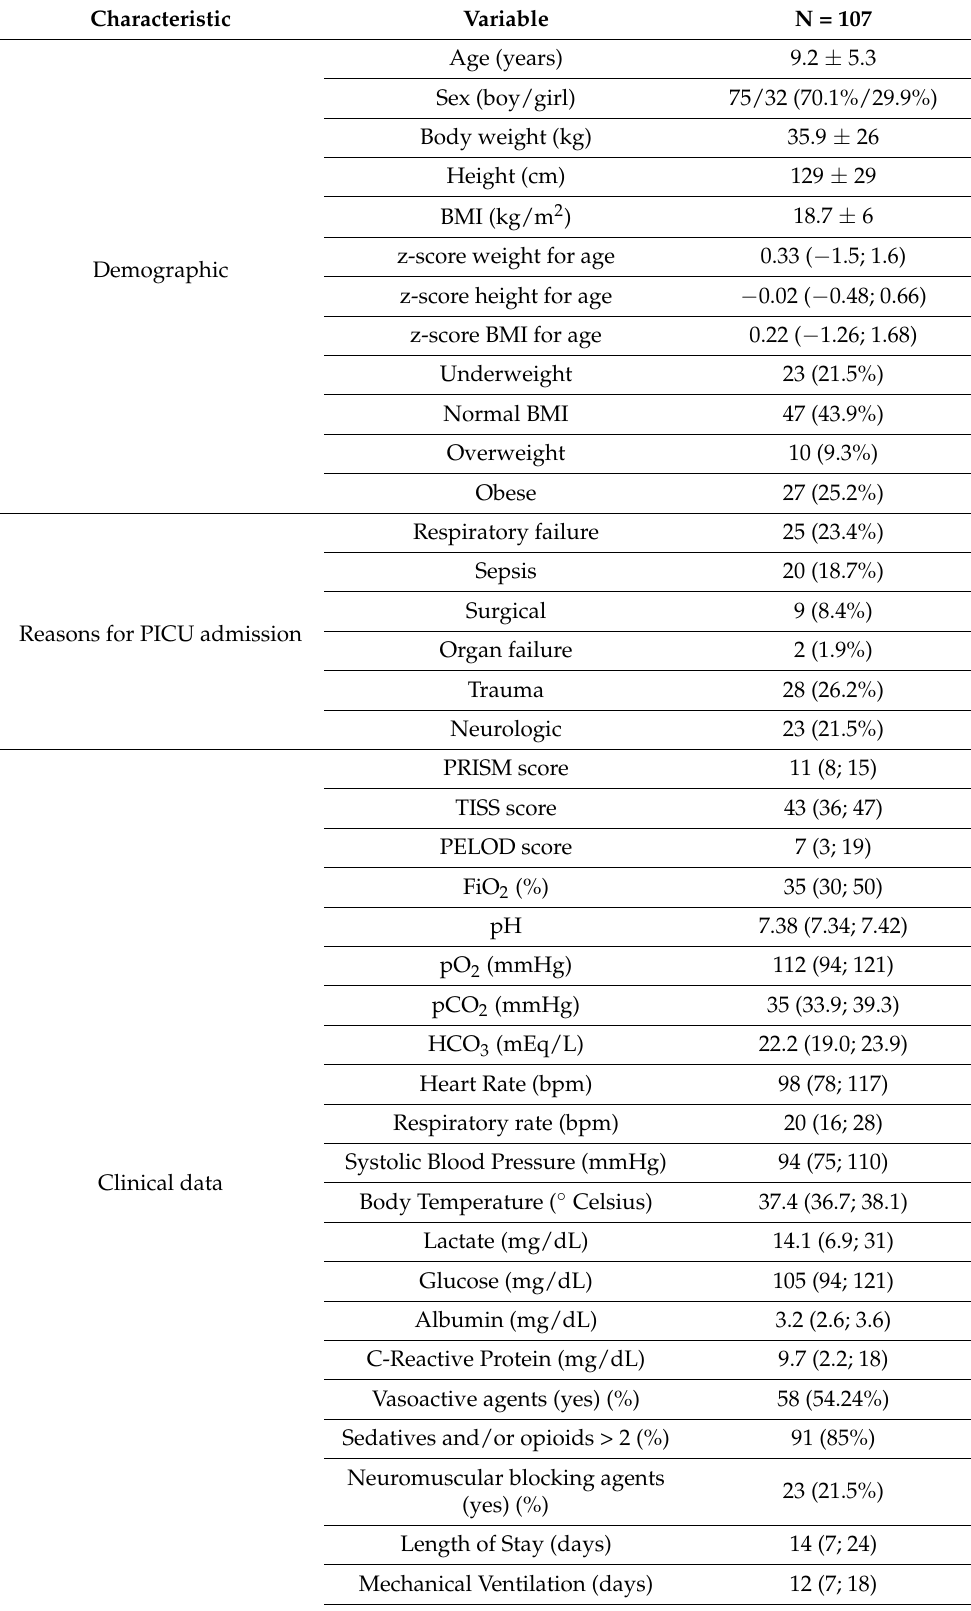
Table 1. Demographic and clinical characteristics of the study